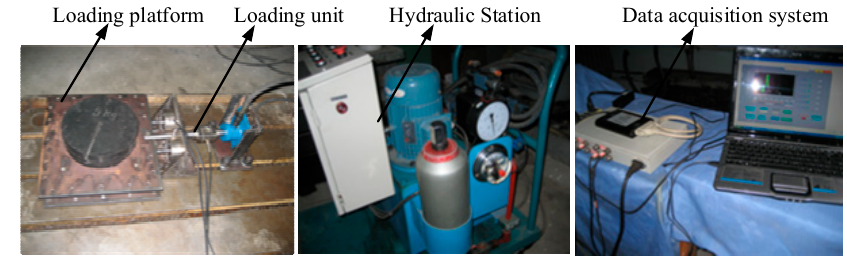
Figure 9. The rolling friction experiment system.